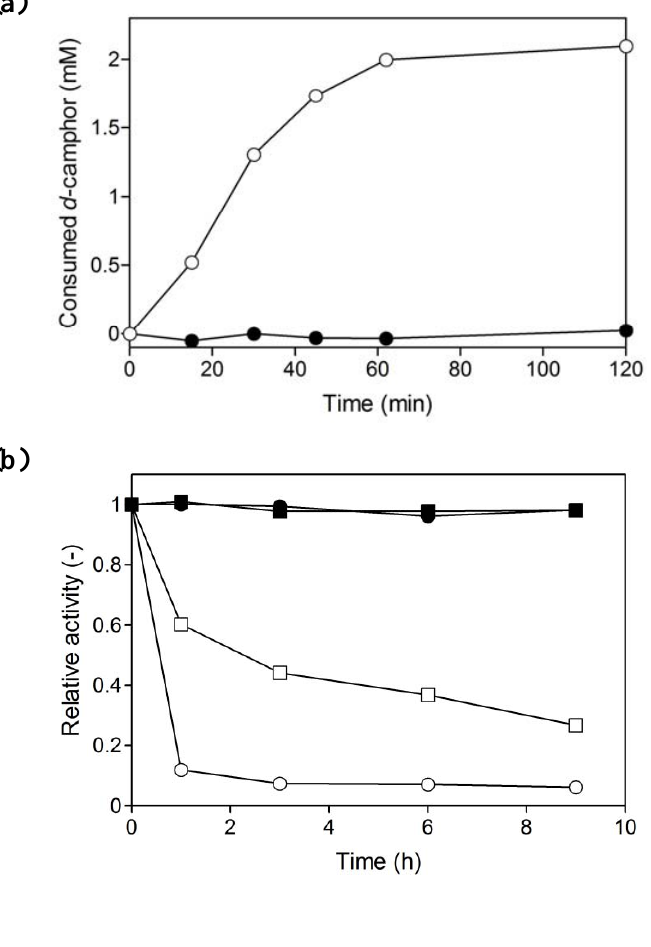
Figure 8. (a) Time course of d -camphor consumption by branched P450cam (open circles) and by an equimolar mixture of P450cam, PdX and PdR (closed circles) in the presence of A . pernix ADH at a W of 16.7. (b) The stability of branched P450cam (open symbols) and 0 of A . pernix ADH (closed symbols) in the reversed micellar system at a W (circles) and in an aqueous solution